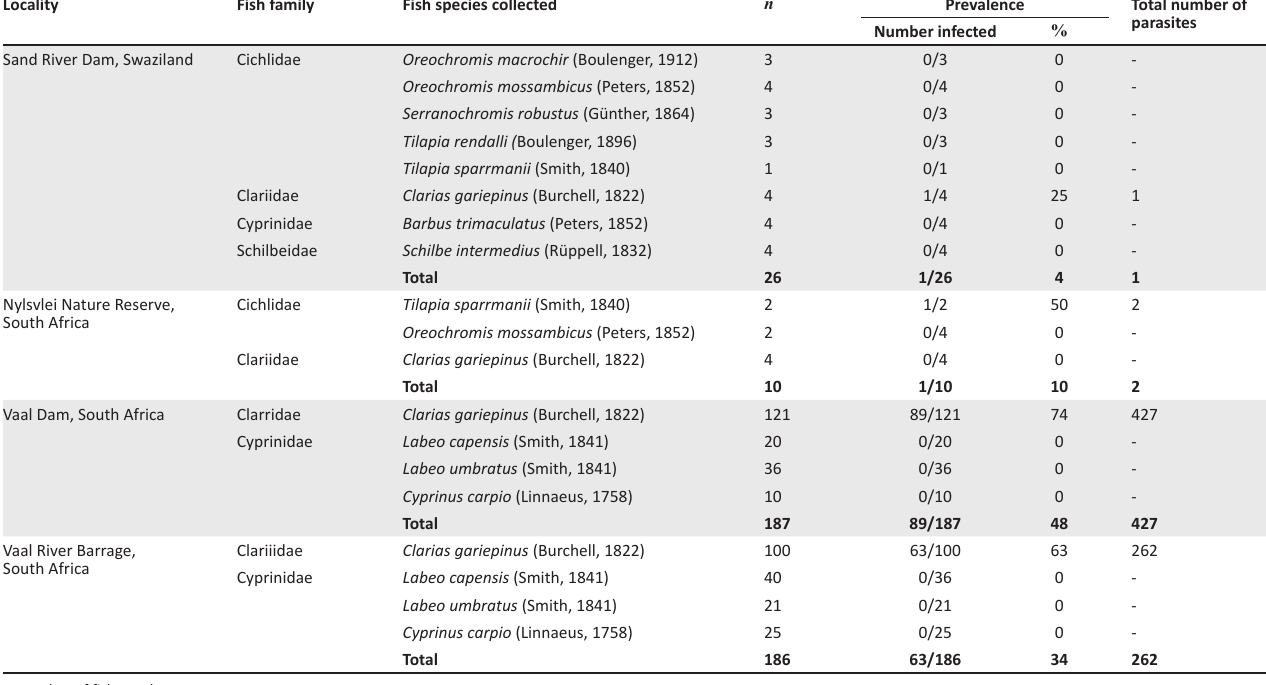
TABLE 1: Fish species collected, total number of fish, prevalence and total number of fish hosts infected with trypanosomes from the Sand River Dam, Swaziland, Nylsvlei Nature Reserve, South Africa, Vaal Dam and Vaal Barrage, South Africa. Locality